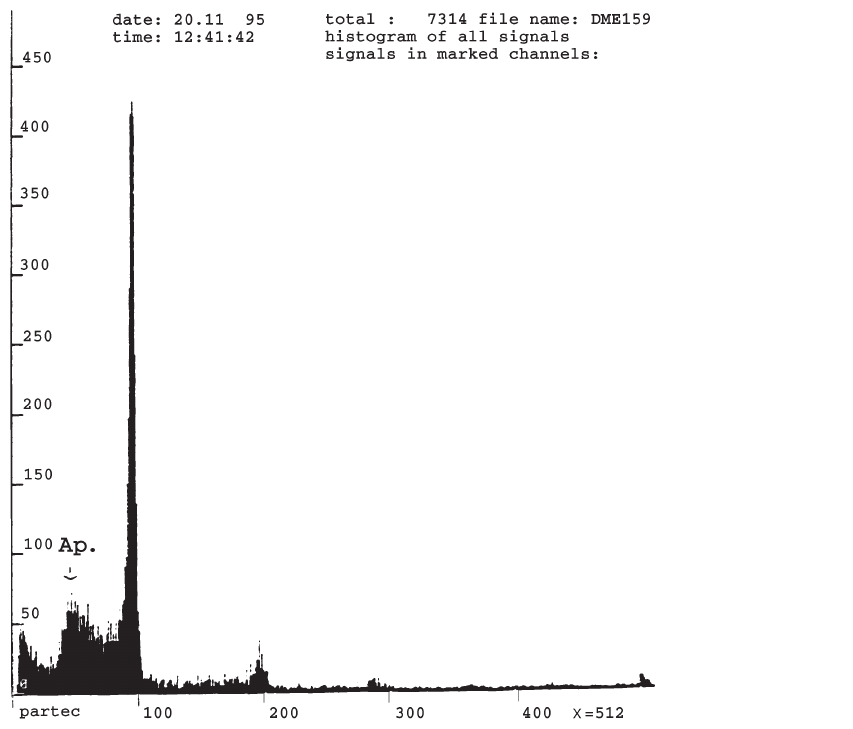
Fig. 2. Univariate DNA distribution of a colorectal mucosal biopsy. Subdiploid apoptotic cells are